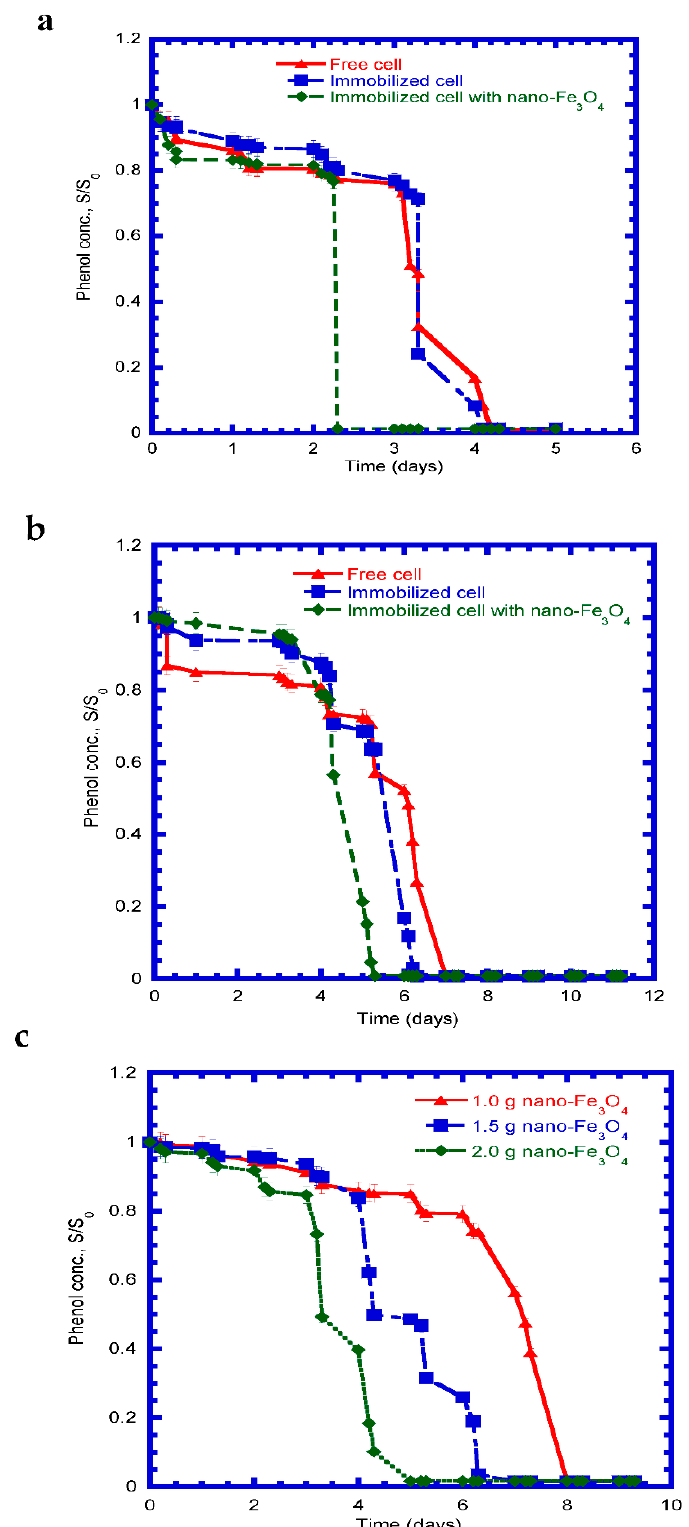
Figure 7. Phenol degradation by Pseudomonas putida in free cells, immobilized cells, and immobilized cells with nano-Fe 3 O 4 in the batch reactors: ( a ) initial phenol concentration is 199.6 mg/L, ( b ) initial phenol concentration is 388.6 mg/L, and ( c ) initial phenol concentration of different dosages of nano-Fe 3 O 4 .